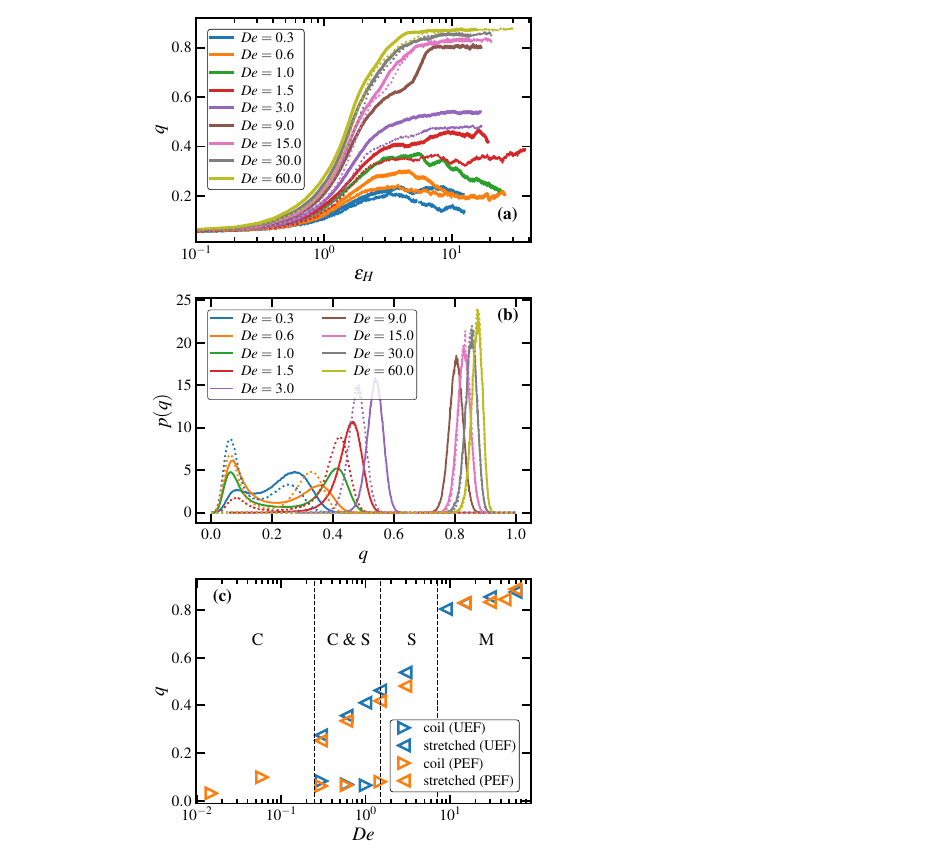
Figure 8. ( a ) Transient order parameter, q , as a function of Hencky strain, ε H , at various values of De for startup of UEF and PEF of the PE melt at 450 K. ( b ) Steady-state probability distribution functions, p ( q ) , of the order parameter at various values of De under UEF and PEF. ( c ) Steady-state order parameter vs. De for both UEF and PEF simulations. Vertical dashed lines define approximate boundaries of the various states or phases. Symbols C, S, and M denote coiled liquid, stretched liquid, and monoclinic semicrystalline states, respectively. The solid curves in panels ( a , b ) depict UEF data, whereas the dashed lines represent PEF data. Note that De = 1.0 and 9.0 were not simulated under PEF, and De = 0.015, 0.06, and 45.0 were not simulated under